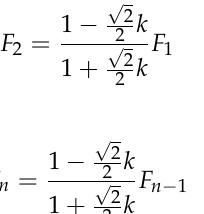
Tensile segment of